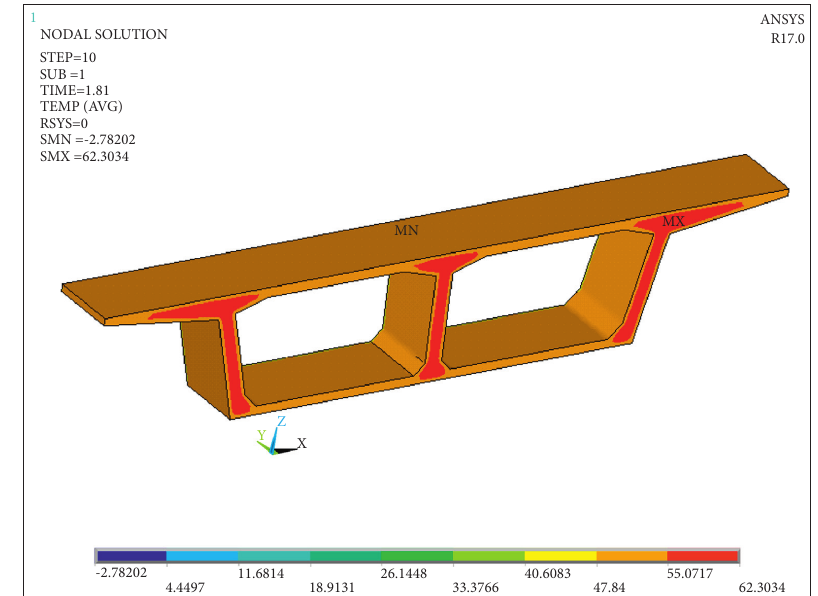
Figure 14: Simulated box girder temperature field after 40h